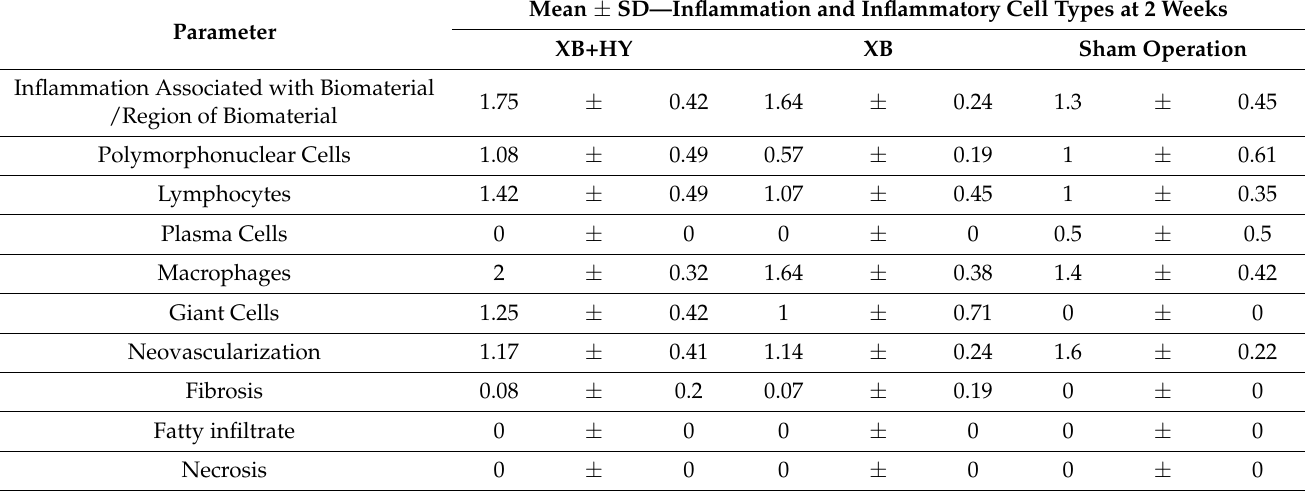
Table 1. Results of the scoring evaluation at 2 weeks post implantationem.